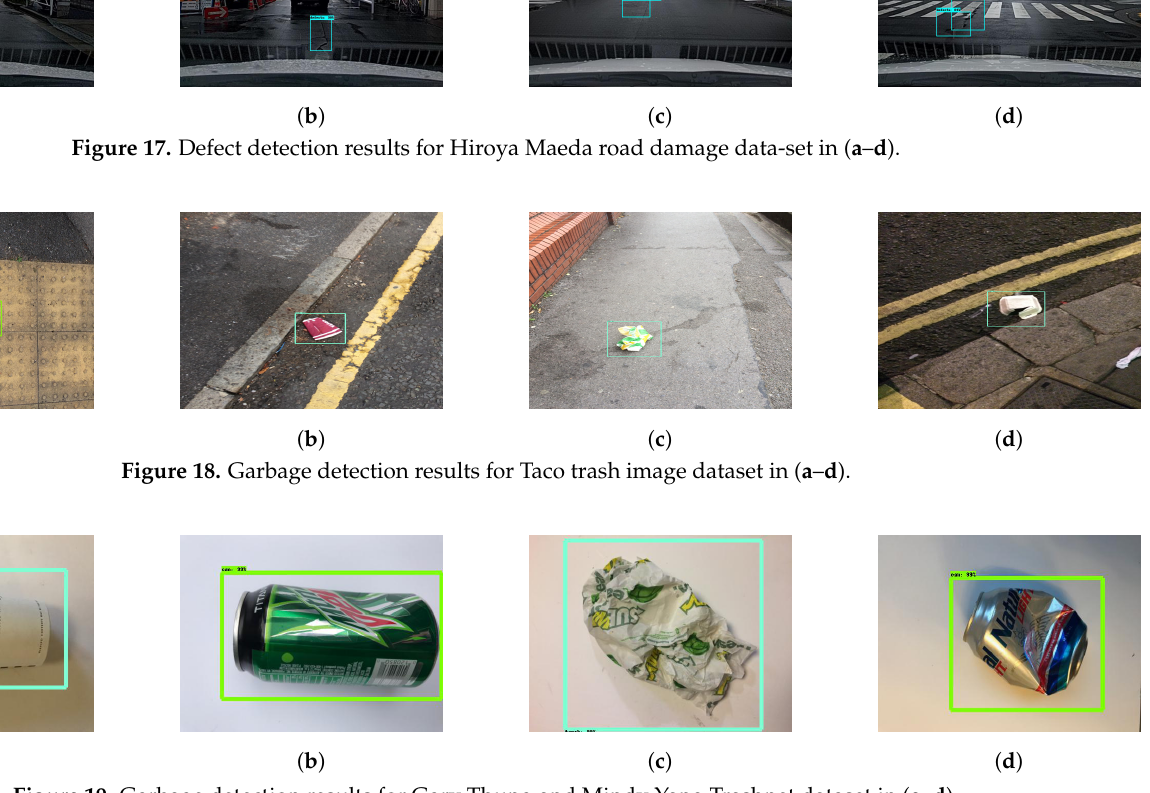
Figure 19. Garbage detection results for Gary Thung and Mindy Yang Trashnet dataset in ( a – d ).